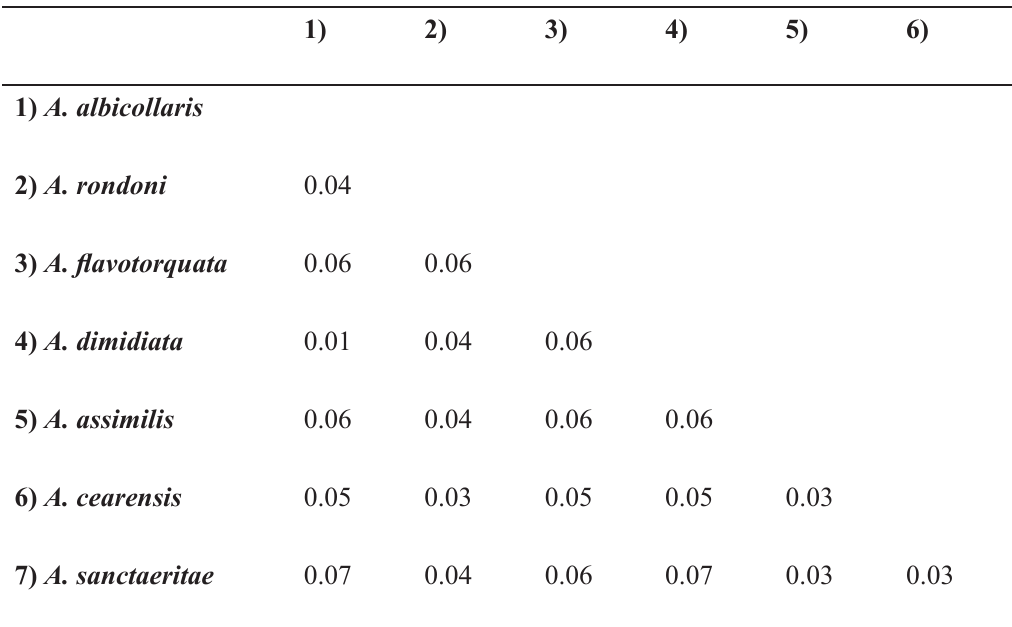
Table 2. Pairwise genetic distances for the 12S gene among sequences of Apostolepis Cope, 1862 analyzed.